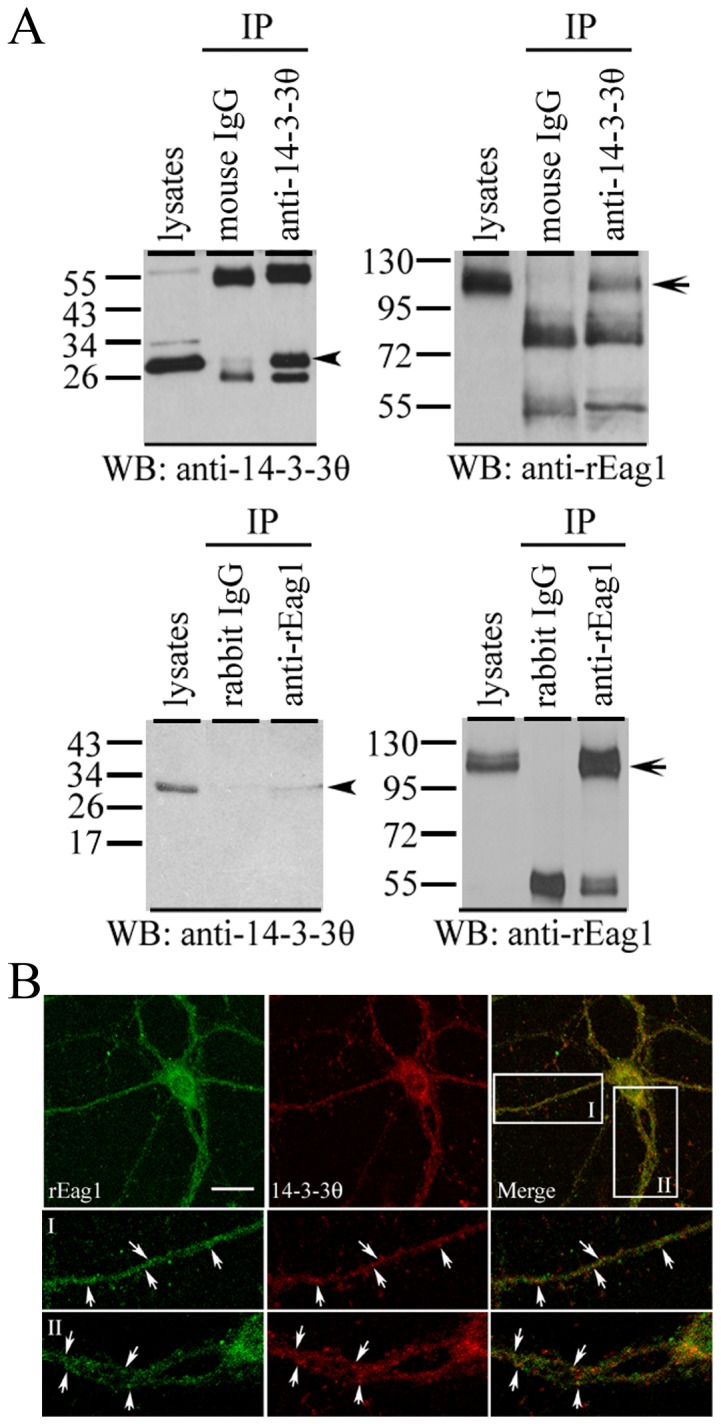
Endogenous expression of 14-3-3θ and rEag1 in neurons.
(
A
) Co-immunoprecipitation of 14-3-3θ and rEag1. Detergent solubilized proteins from the lysates of rat forebrain were immunoprecipitated (IP) with the anti-14-3-3θ (upper panel) or the anti-rEag1 antibody (lower panel), followed by immunoblotting (WB) analyses with the anti-14-3-3θ or the anti-rEag1 antibody. The non-immune mouse or rabbit IgG was used in parallel as negative control. Input volumes correspond to 5% of the total cell lysates used for immunoprecipitation. The arrowhead and arrow refers to the protein bands of 14-3-3θ and rEag1, respectively. (
B
) Immunofluorescence staining of rEag1 (left panels) and 14-3-3θ (middle panels) in cultured hippocampal neurons. The area highlighted in the white boxes is viewed under a higher magnification (I, II). Arrows label the sites of co-localization of 14-3-3θ and rEag1 (right panels), which displayed significant punctuate patterns over a wide region along the neurites. Scale bar, 25 µm. These co-immunoprecipitation and immunofluorescence data are representative of four to seven independent experiments.